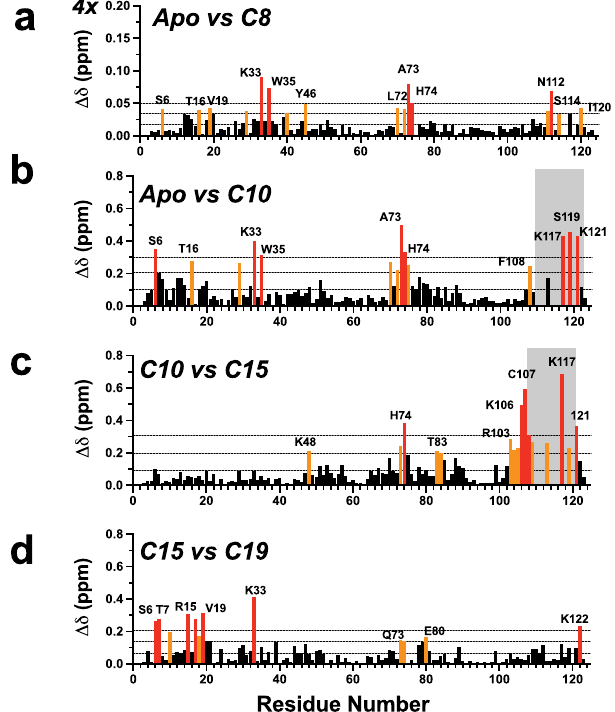
Figure 5. Chemical shift changes as a function of fatty acid chain length. Comparison of chemical shift differences in the 1 H- 15 N HSQC spectra recorded at 600 MHz for (a) apo compared to octanoic acid. (b) Apo versus C10. (b) C10 acid vs C15 acid and (d) C15 vs C19 acids. Significant chemical shift perturbations are color coded as in Fig. 1. In panel (a), the vertical scale has been expanded by four compared to the other panels. For C10–C14 conformational averaging in the C-terminal tail limited the assignments for a number of residues in this region (shaded in grey in b and c). In all cases the protein was at ~100 μ M and the fatty acid was present at a concentration of 200 μ M in sodium phosphate at pH